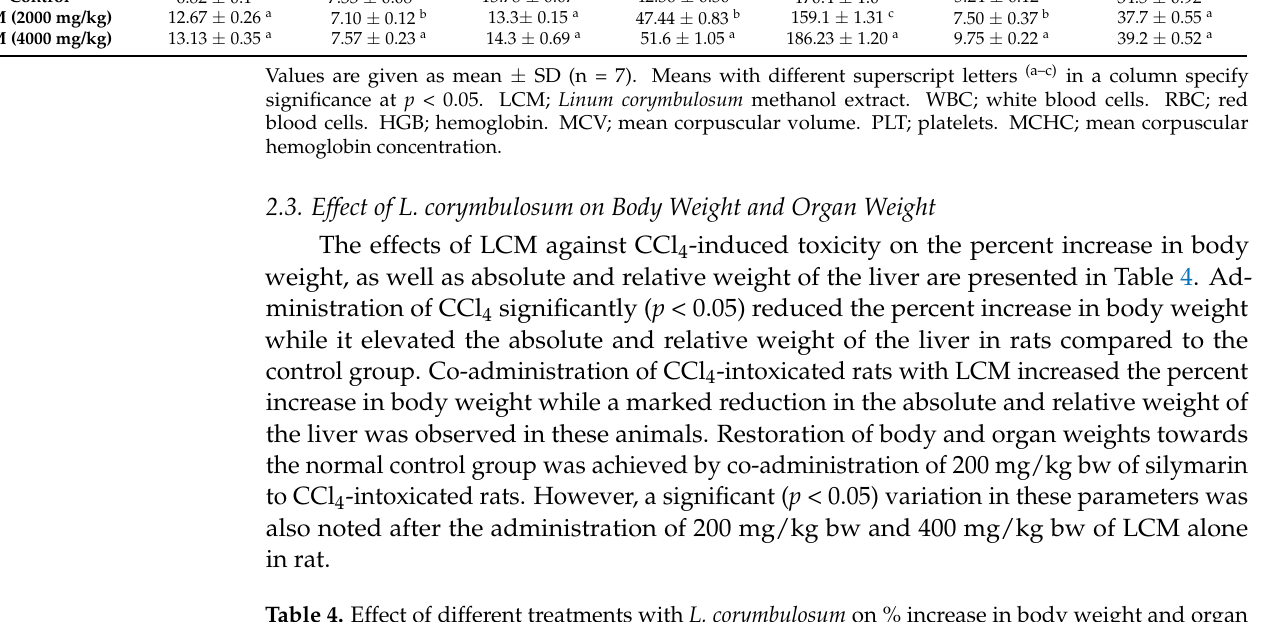
Table 4. Effect of different treatments with L. corymbulosum on % increase in body weight and organ weight of